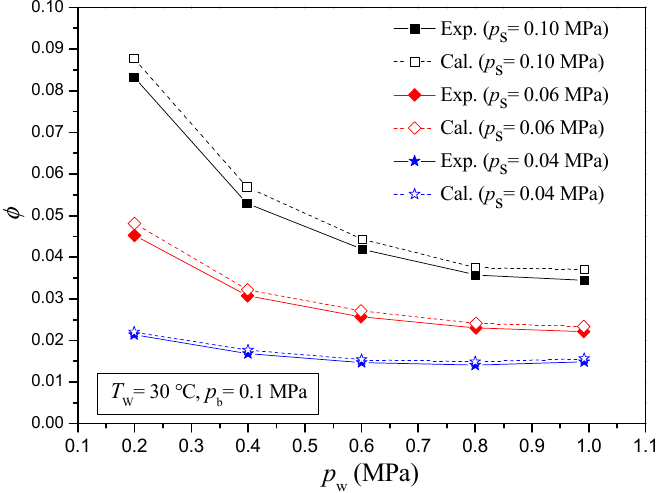
Figure 6. ϕ comparisons for different inlet water pressures. Figure 6. φ comparisons for different inlet water pressures.